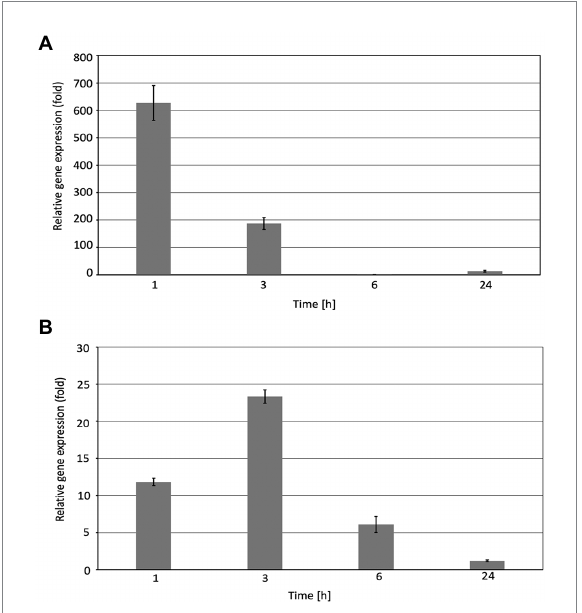
FIGURE 1 Relative EGY3 gene expression in Arabidopsis thaliana leaves exposed to heat stress (A) or high light (B) . Arabidopsis thaliana plants were exposed to 1,000 μ mol m − 2 s − 1 or for 40 ° C for 1 h, 3 h, 6 h, and 24 h, and then, the total RNA was isolated from leaves and transcribed into cDNA used as a template for the quantitative real-time PCR, according to the description in the Material and Methods. CYP5 and ALDH3 were used as an endogenous control for the analysis of plants exposed to high light or heat stress, respectively. ± means standard deviation of six replication, an asterisk indicates a statistically significant change compared to the 0 h time base